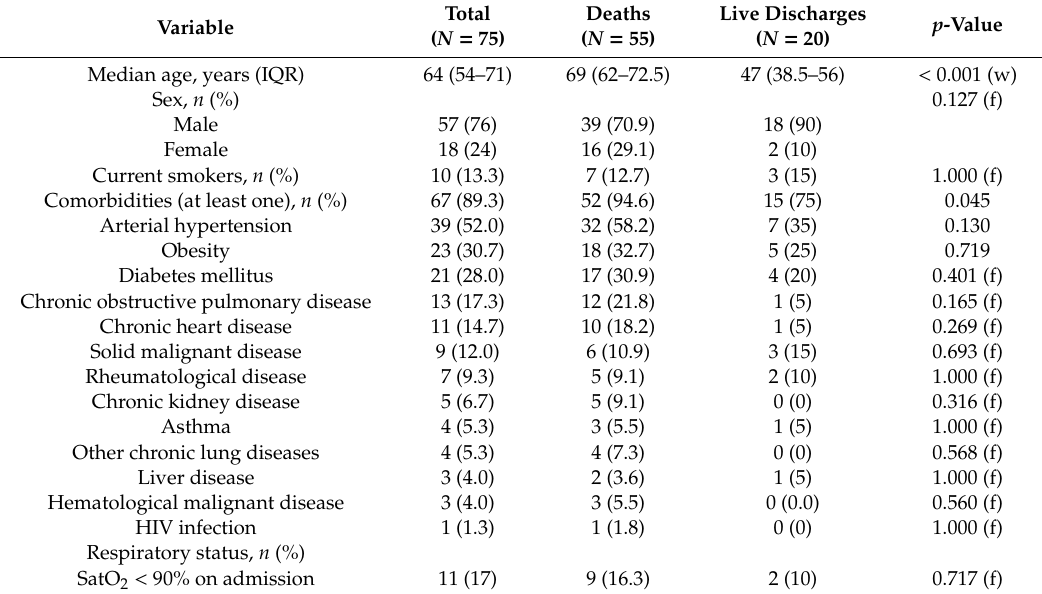
Table 2. Demographics, Comorbidities and Respiratory Status on Admission of the Intensive Care Patients.